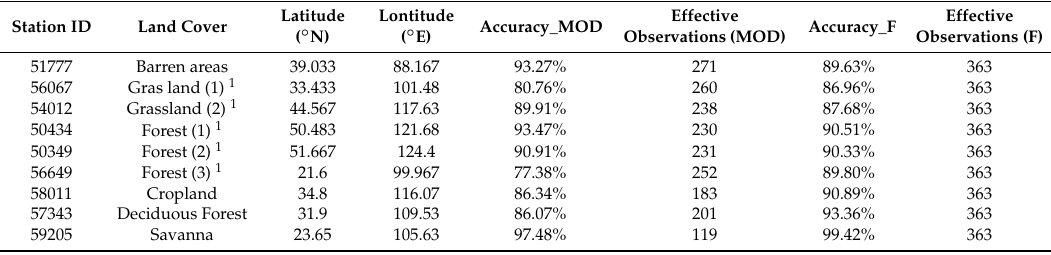
Table 2. Comparision of F/T status determined by the MODIS LST threshod (0 ◦ C) and fused F/T maps.